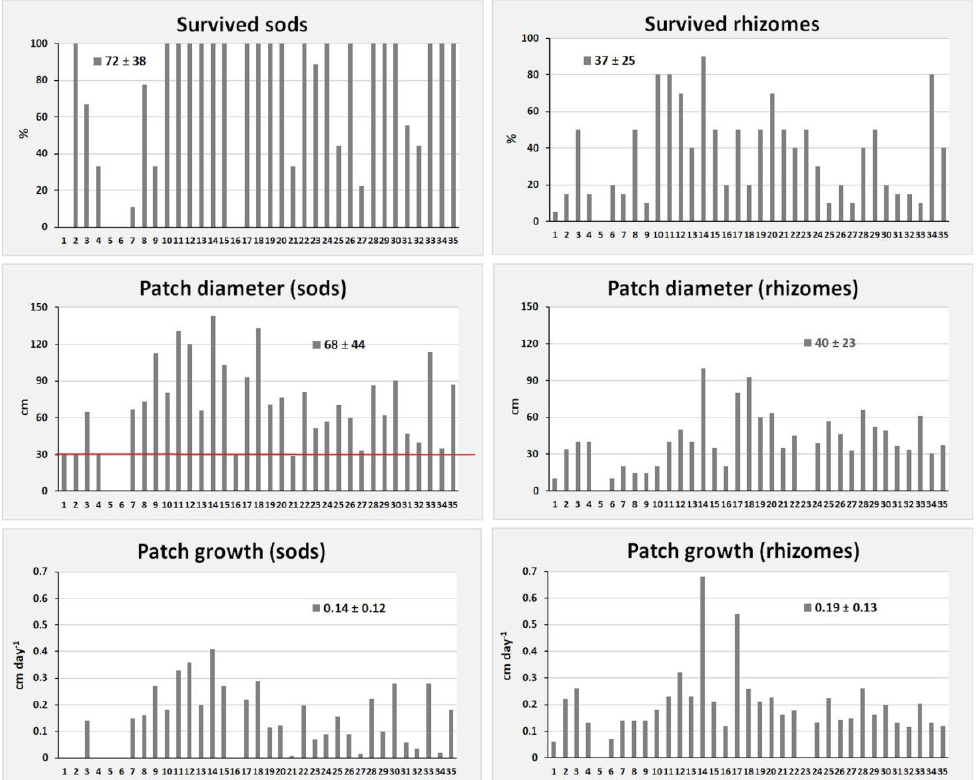
Figure 4. Percentage, patch diameter, and daily growth of survived sods and rhizomes.